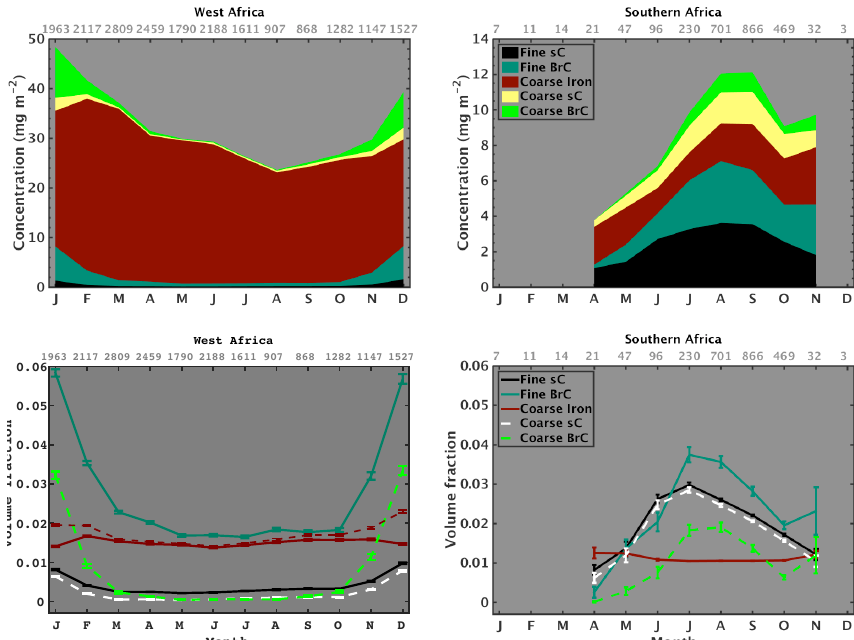
Figure 9. Upper panels: monthly averaged column concentrations of retrieved sC, BrC, and free iron in the fine and coarse modes at the West African and southern African sites (fine mode iron is negligible at these scales). Note the difference in y axis scales. Lower panels: monthly averaged volume fractions at the same sites. Extra dashed maroon line for West Africa indicates monthly averages for coarse mode iron, but computed without using retrievals that require branch D of Fig. 6. Error bars represent the SD of the means. Number of retrievals per month shown along upper axes; only months with more than 20 retrievals are shown in plots.